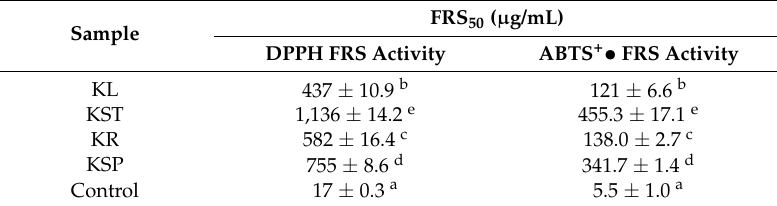
Table 1. Half maximal Free radical scavenging (FRS 50 ) value by extraction part of kudzu for antioxidant systems.